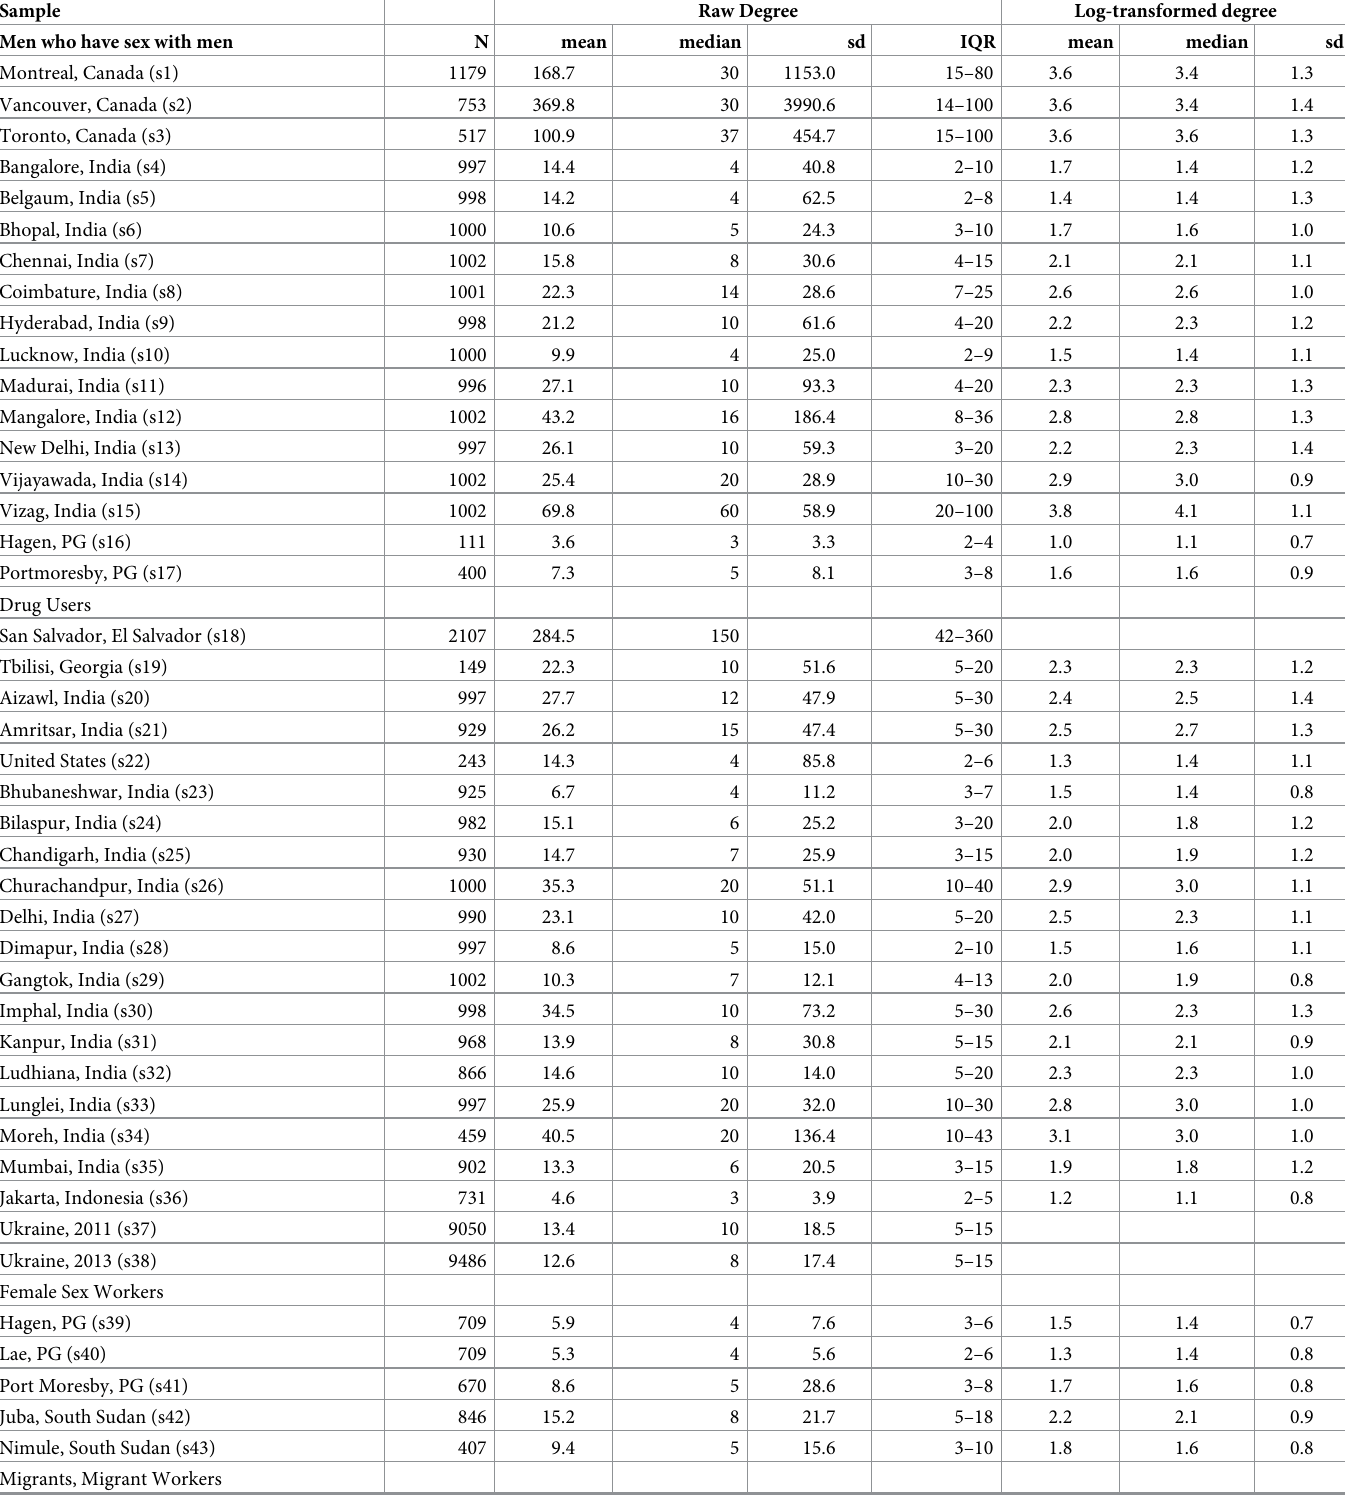
Table 3. Distribution of raw reported degree and log-transformed degree across samples.